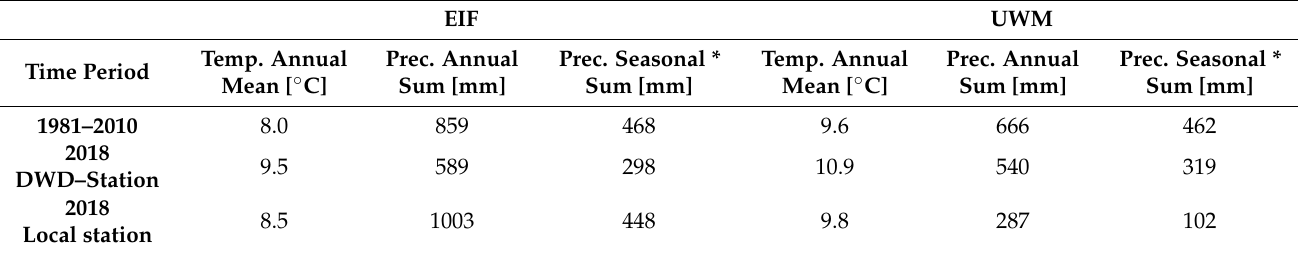
* The seasonal precipitation sum corresponds to the growing season (here from April to